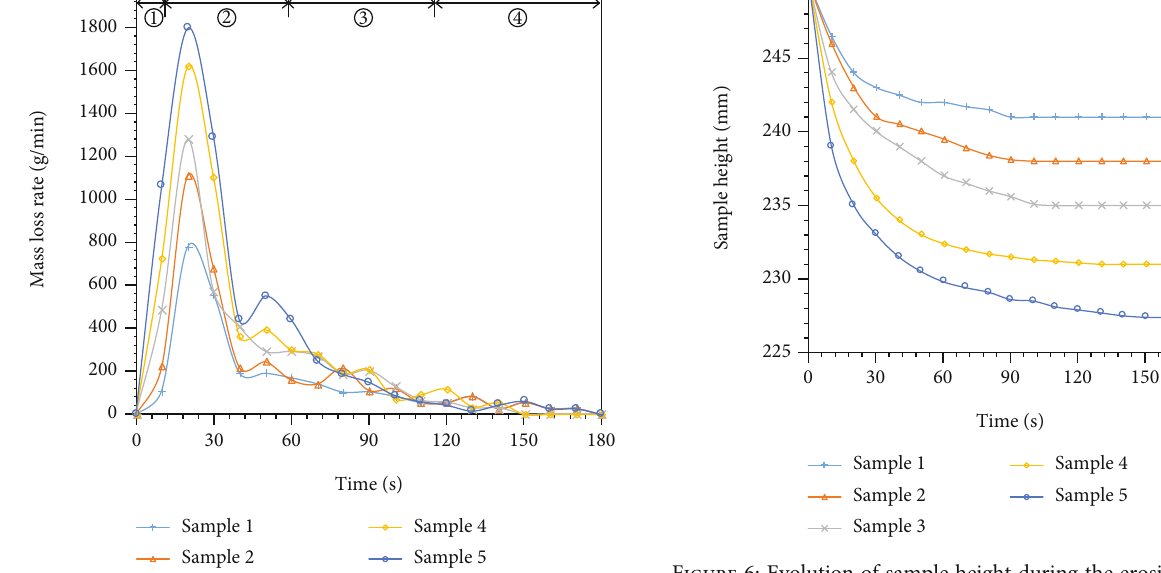
Figure 6: Evolution of sample height during the erosion